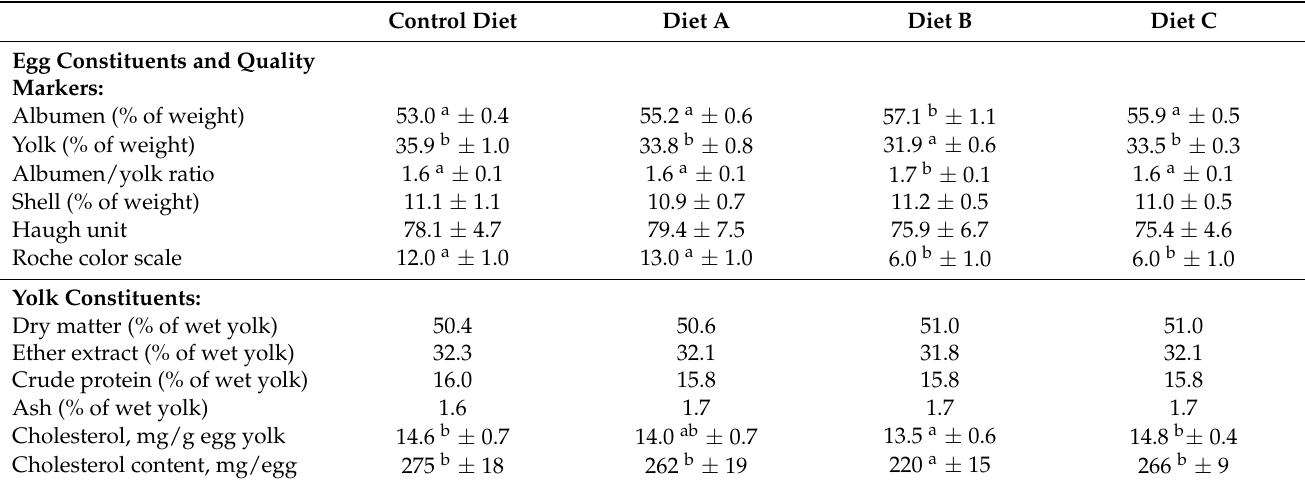
Table 4. The compositional analysis and quality assessment of eggs ( n = 10 per group) laid by hens fed a commercial corn/soymeal poultry diet (Control), the same diet with added isoflavone glycosides from soy germ (diet A), the same diet with isoflavone aglycons from milled soy germ pasta (diet B) and the Control diet with commercial pasta devoid of isoflavones (diet